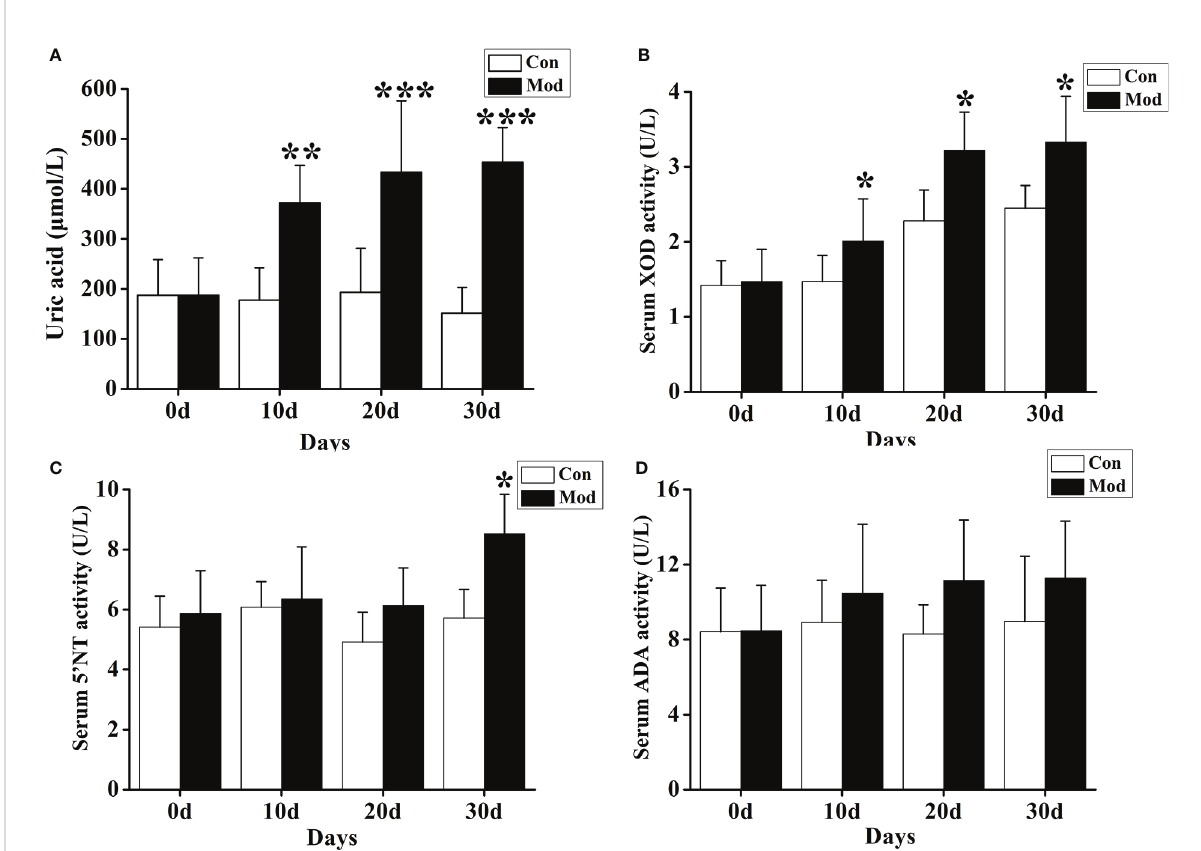
FIGURE 3 Increased uric acid level and expression of related uric acid production and metabolism enzymes. (A) The serum uric acid level. (B) The XOD activity in the serum. (C) The 5 ’ -NT activity in the serum. (D) The ADA activity in the serum. Data are expressed as mean ± SEM for 8 quails in each group. * P < 0.05, ** P < 0.01 and *** P < 0.001 versus Con